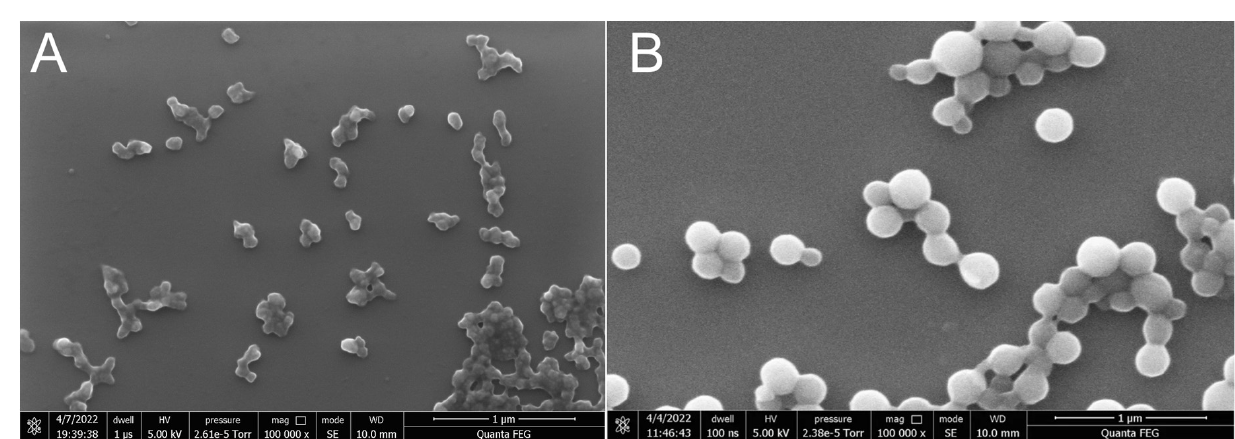
Figure 2. SEM images of PB@BSA5 ( A ) and BSA NP ( B ) nanoparticles. Scale bars—1 μ m.